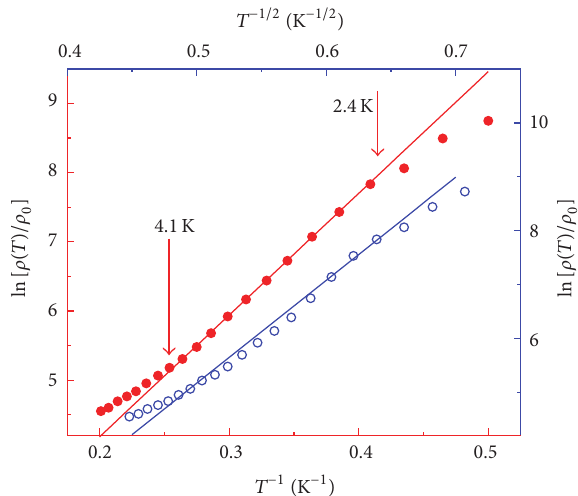
Figure3:ln 𝜌 versus 𝑇 −1 (redsymbols),leftandbottomredaxis.ln 𝜌 versus 𝑇 −1/2 (blue symbols), right and upper blue axis. Solid lines are the result of the best linear fit in these coordinates. Data are for 𝐻 = 0